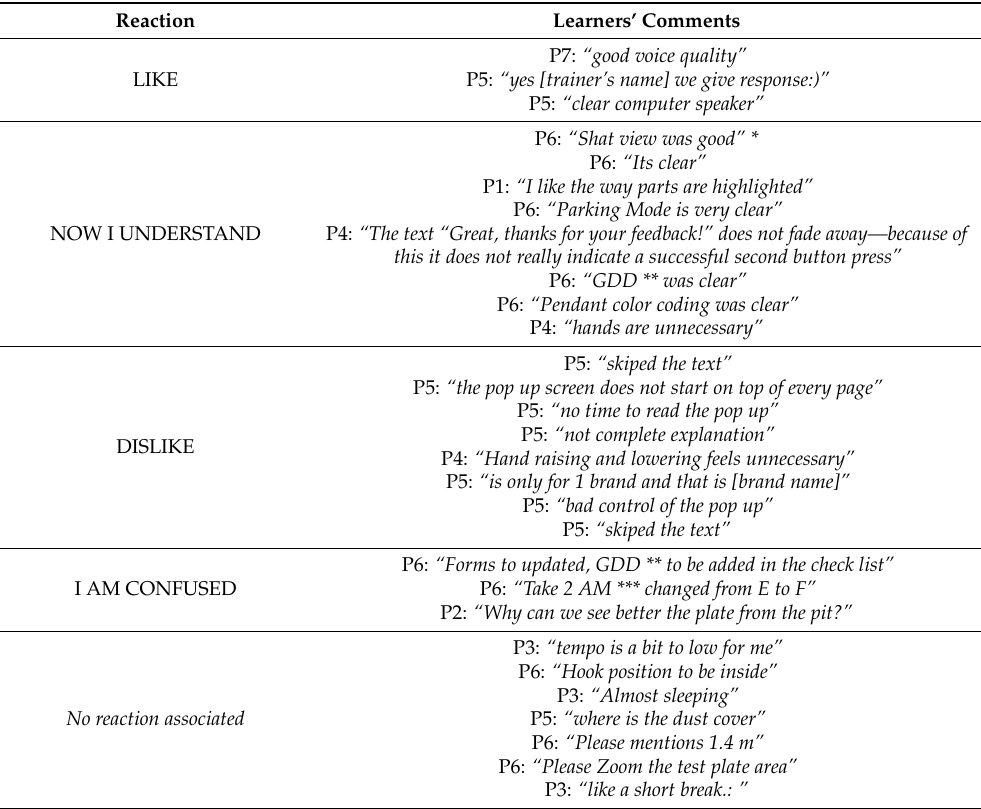
Table 1. Free-form text feedback categorized by associated reaction